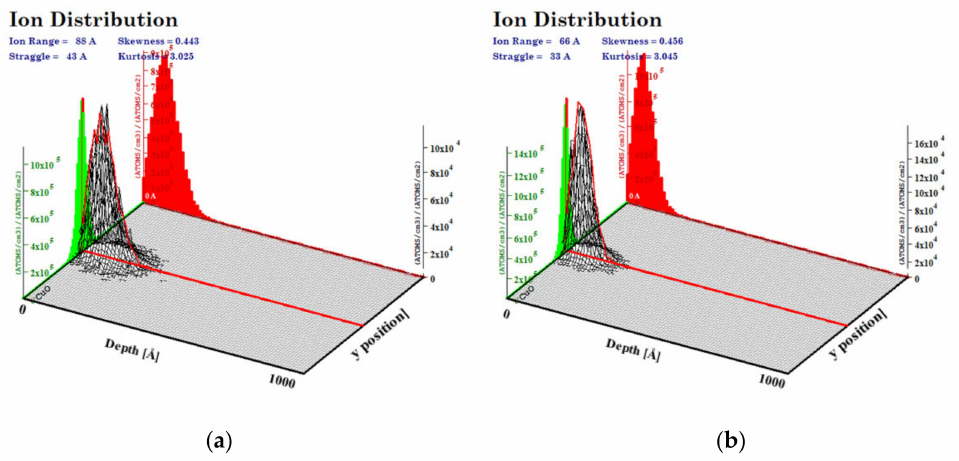
Figure 2. Range of implanted ions in CuO calculated with SRIM program for energy of ( a ) 15 keV, ( b ) 10